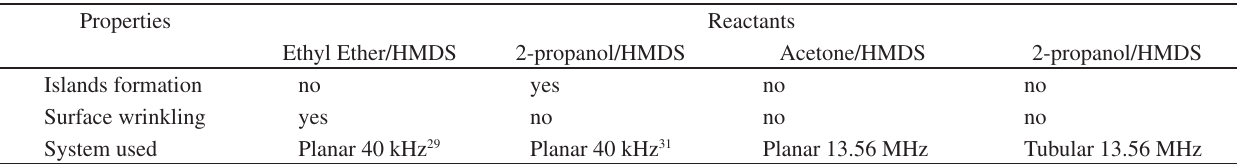
Figure 6. Typical FTIR spectra: a) HMDS (0.5 Torr, 250 W, 380 Å) and acetone (1.0 Torr, 250 W, 100 Å) double layer; and b) For HMDS (50 W; 500 mTorr; 1000 Å) and 2-propanol (150 W; 1.0 Torr; 3000 Å) double layer films obtained using a planar plasma reactor coupled with a 40 kHz power supply. Table 4. Results for island formation when double layer deposition is